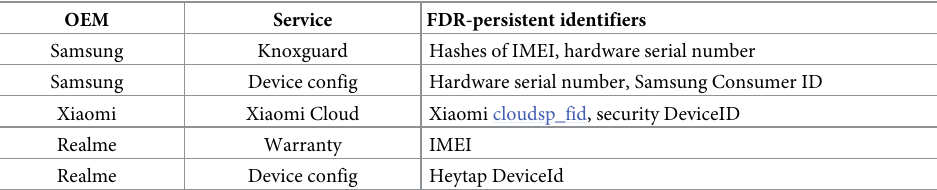
Table 1. FDR-persistent identifiers used in network connections associated with OEM system